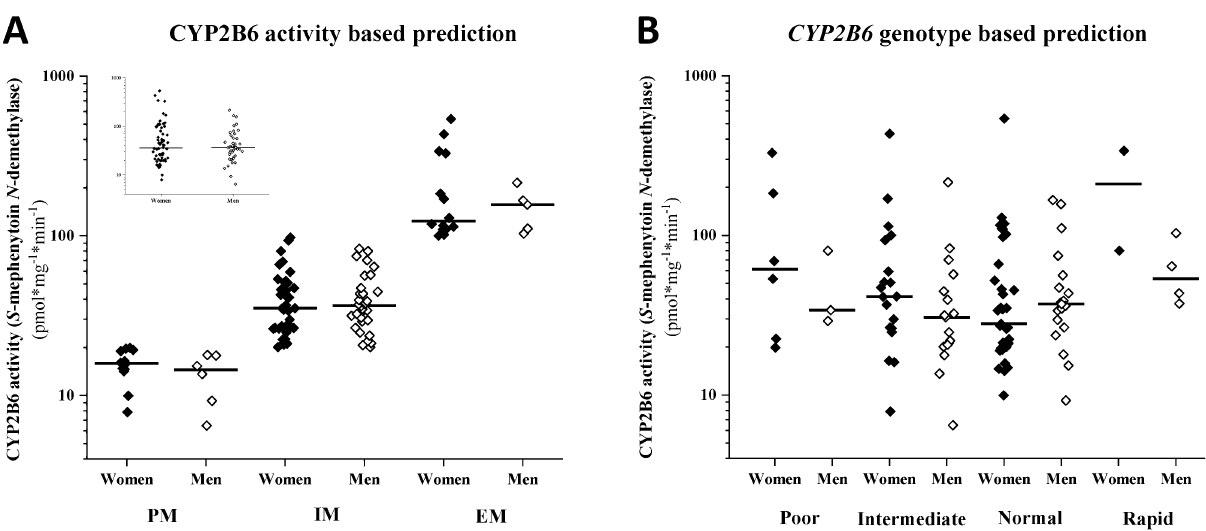
Figure 1. Frequency distribution of hepatic CYP2B6 activities ( S -mephenytoin N -demethylation) (N = 105) ( A ) and association between CYP2B6 activities and mRNA expression (N = 85) ( B ) in human tissue donors. PM poor metabolizer; IM intermediate metabolizer; EM extensive metabolizer. * Significant difference ( P < 0.0001).